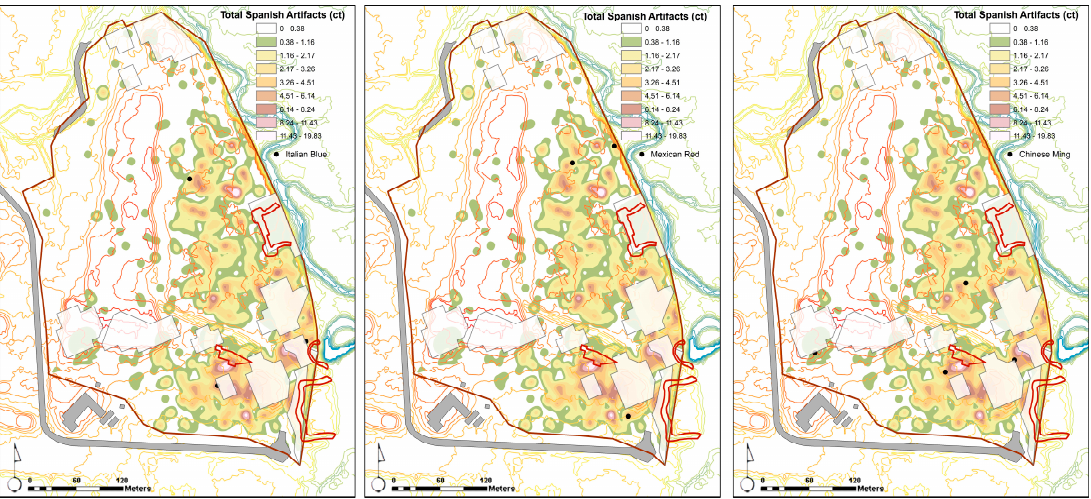
Figure 22. The distribution of all Spanish period artifacts and the location of shovel tests yielding Italian Blue ceramics ( left ), Mexican Red ceramics ( center ), and Chinese Ming Dynasty ceramics ( right ). Areas whited-out were not shovel tested. Contour spacing is 1m. Contours are based on the LiDAR dataset and use the NAD 1983 and NAV 1988 horizontal and vertical datum, respectively.